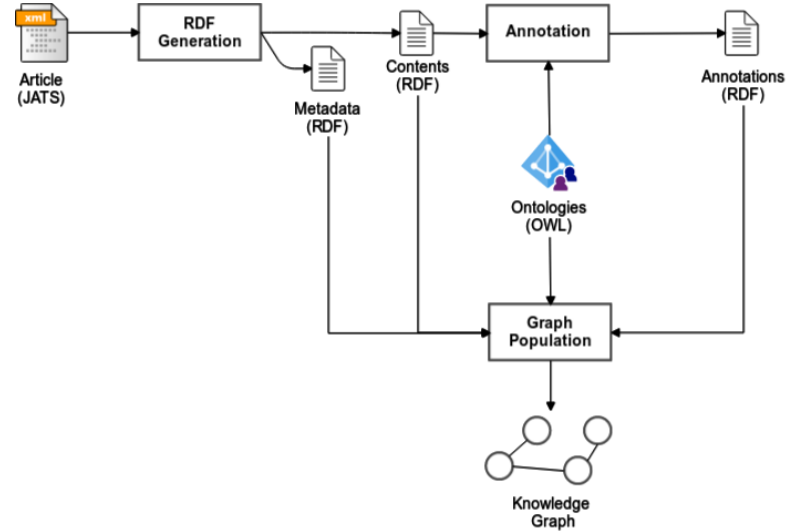
Figure 1. General overview of the pipeline used for generating a knowledge graph from the scientific